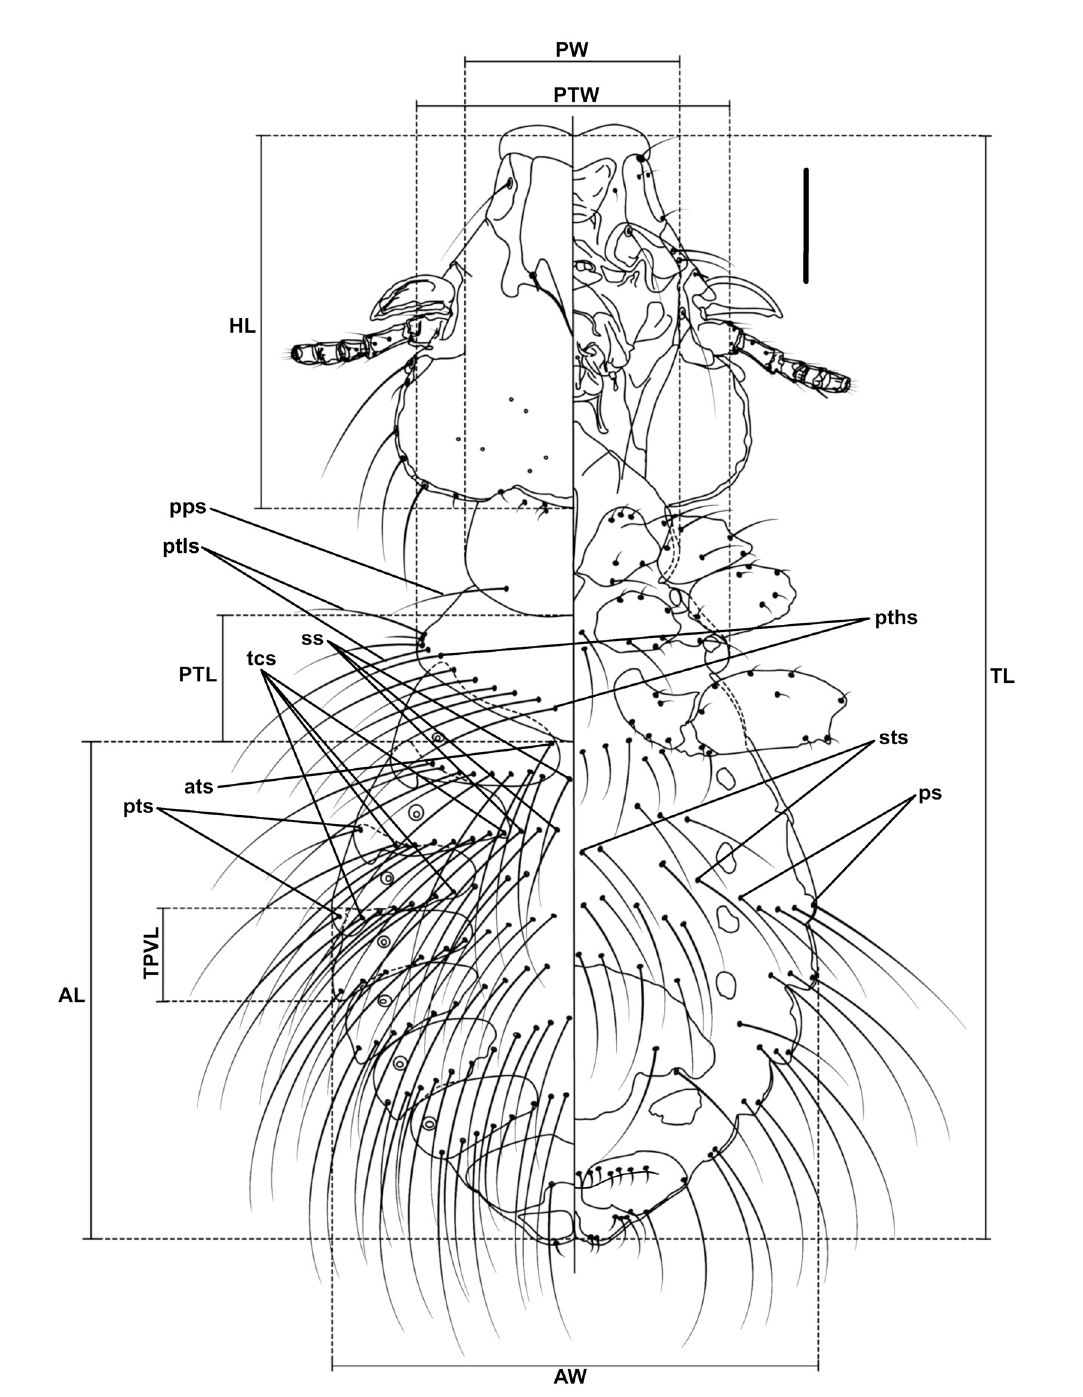
Fig. 3. Philopterus acrocephalus Carriker, 1949 ex Acrocephalus melanopogon (SK25 in MMBC): female habitus showing points of measurements and nomenclature of abdominal setae, dorsal and ventral views. Abbreviations: setae: ats – anterior tergal seta; ps – paratergal seta; pps – pronotal post- spiracular seta; pths – pterothoracic seta; ptls – pterothoracic lateral seta; ss – sutural seta; sts – sternal seta; tcs – tergocentral seta. Measurements: AL – length of abdomen; AW – maximal width of abdomen; HL – head length; PTL – pterothorax length; PW – prothorax width; PTW – pterothorax width; TL – total length; TPVL – tergal plate V length. Scale bars: 0.1